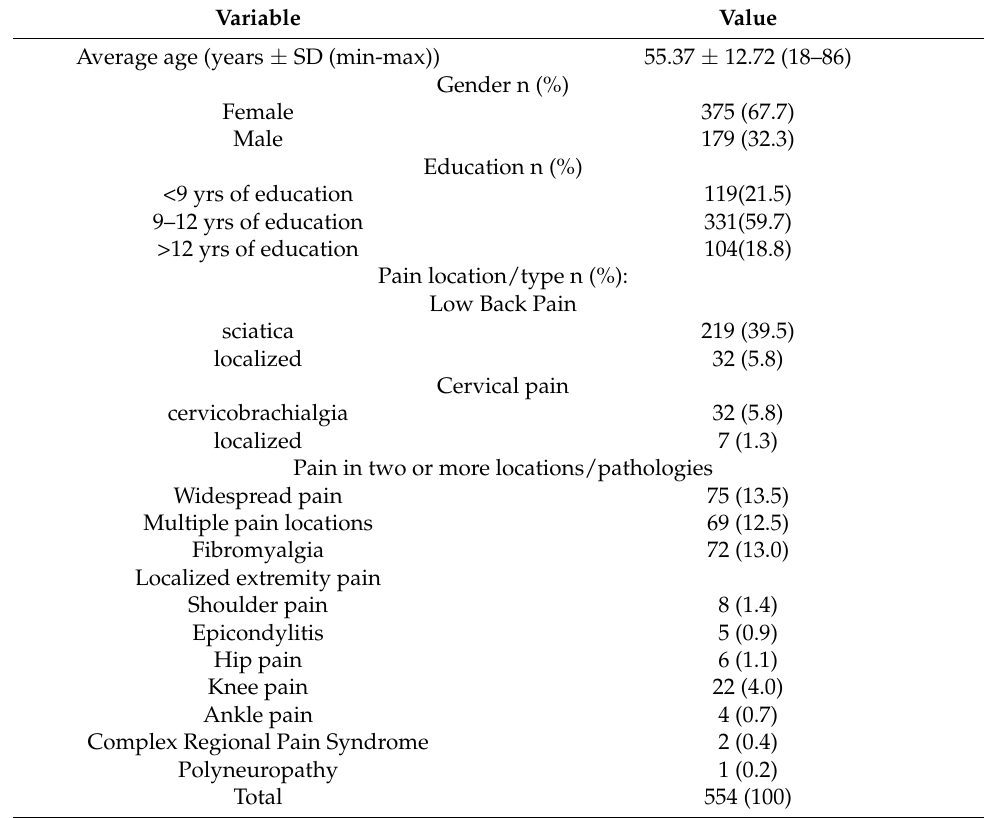
Table 1. Demographic characteristics of the patient sample ( n =